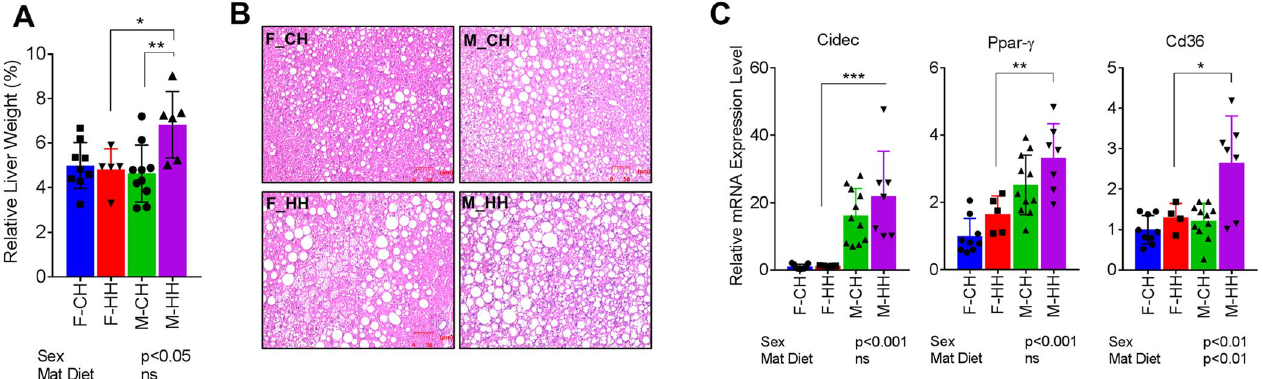
Figure 7. Exacerbated fatty liver phenotype in male offspring from HFD-fed dams. ( A ) Relative liver weights, ( B ) Photomicrographs of hematoxylin and eosin-stained liver sections, and ( C ) mRNA expression of lipogenic genes Cidec, Ppar- γ and CD36 in male and female offspring fed HFD postnatally. Data are expressed as means ± SD. Statistical differences were determined using a two-way ANOVA to examine the effects of maternal HFD and offspring sex, followed by Student-Newman-Keuls post hoc analyses. ( * p < 0.05, ** p < 0.01 *** p < 0.001).